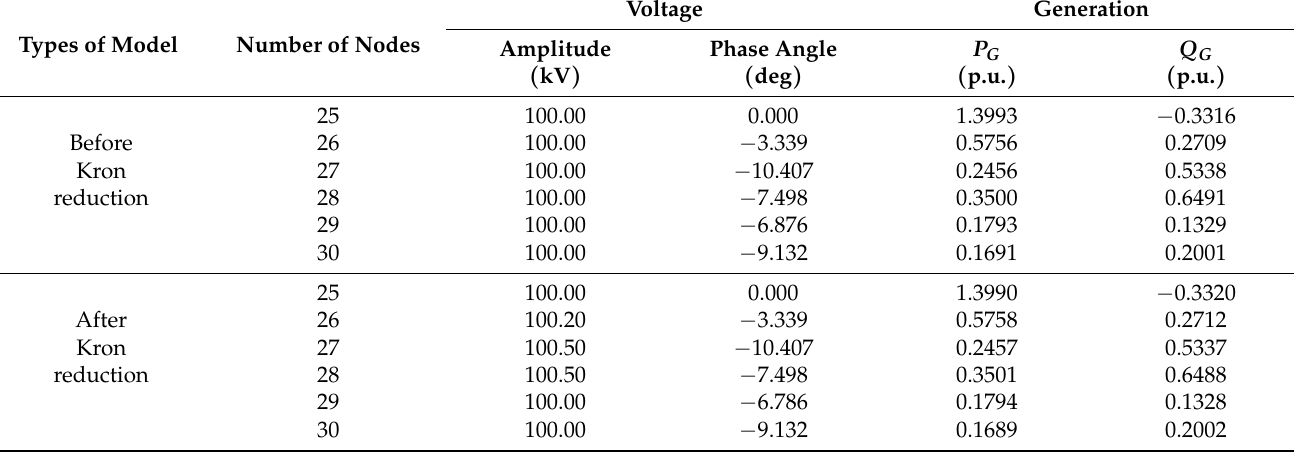
Table 5. The power flow data of preserved nodes before and after